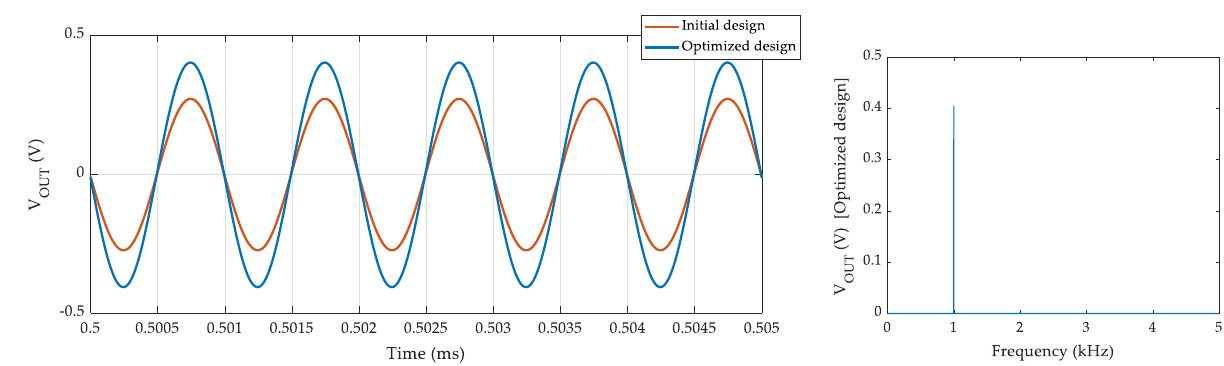
Figure 19. Comparison between the initial design and the optimized design after the first iteration.